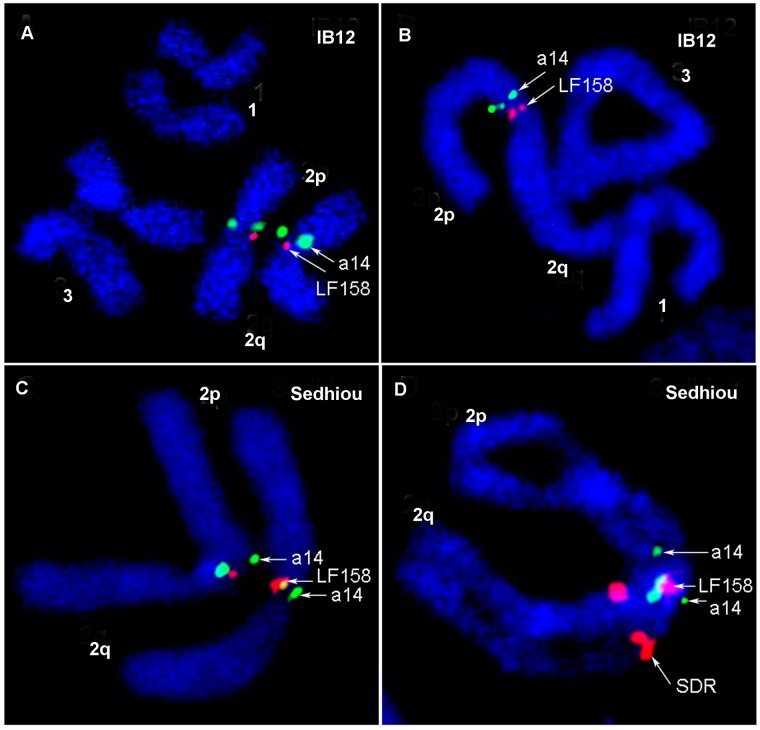
The standard (A, B) and heterozygote (C, D) arrangement of the inversion on chromosome 2 in IB12 and Sedhiou strains respectively.BAC clones are named by genetic markers they are carrying.